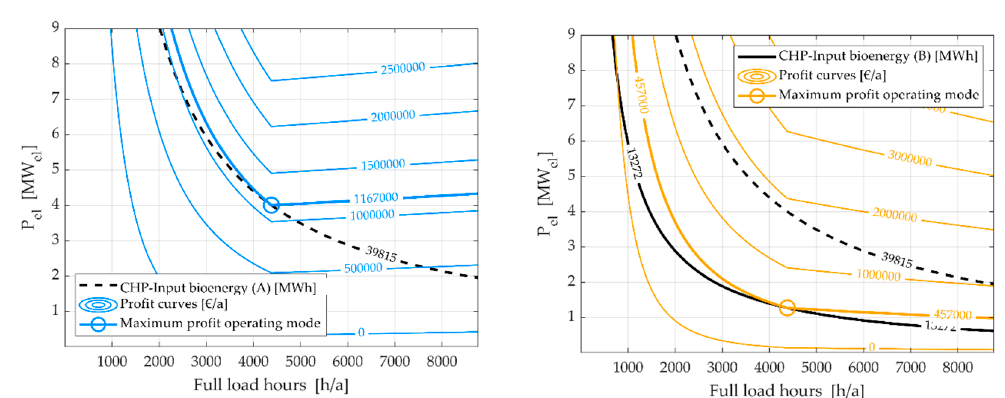
Figure 1. Profit curves for Scenarios A and B.